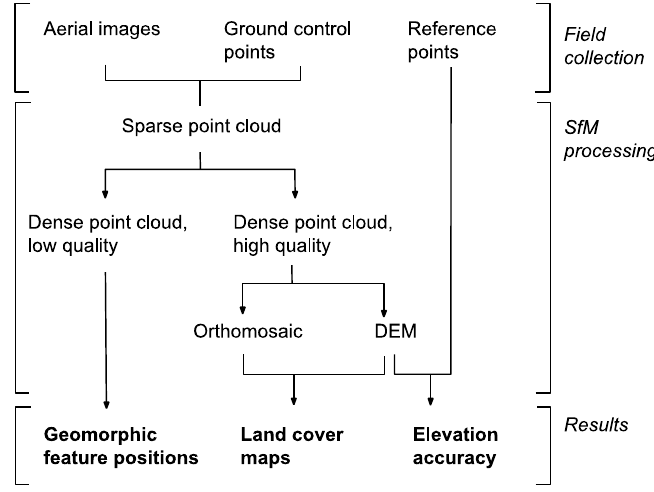
Figure 1. Workflow implemented in the project.